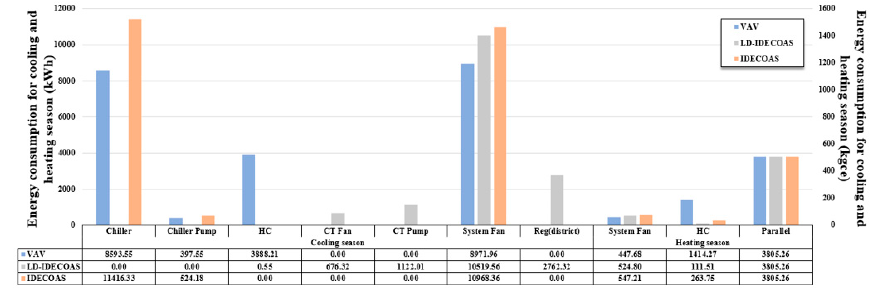
Figure 18. The seasonal energy consumption comparison in Shanghai.